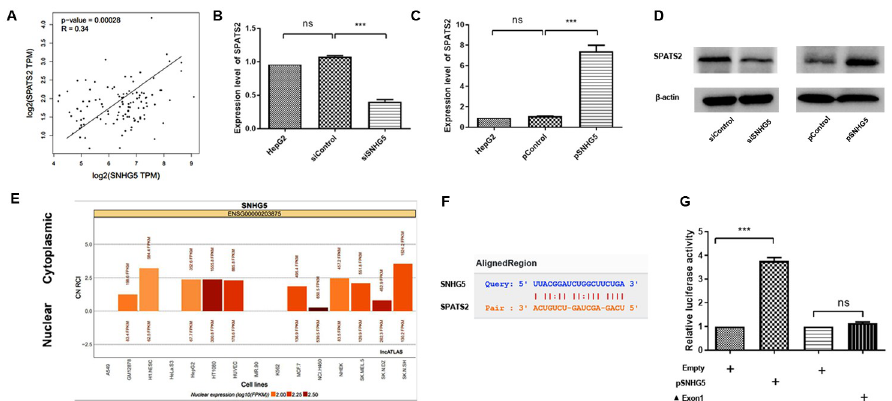
Fig 2. SPATS2 is downstream target of SNHG5 in HepG2 cells. (A) Pearson’s correlation analysis of the relationship between SNHG5 and SPATS2 expression in HCC tissues. (B-D) SPATS2 expression in SNHG5 overexpression- or downregulation-transfected HepG2 cells. (E) Cell location of SNHG5. (F) Sequence alignment of SPATS2 with the putative binding sites in the wild-type regions of SNHG5. (G) A luciferase reporter assay verified the targeted binding effect between the SPATS2 3 0 UTR and SNHG5. The experiment was repeated three times, and a representative blot image is shown. �� p < 0.01, ��� p < 0.001.